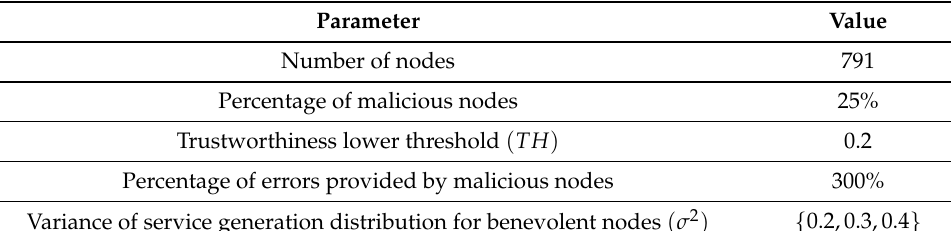
Table 2. Simulation setup